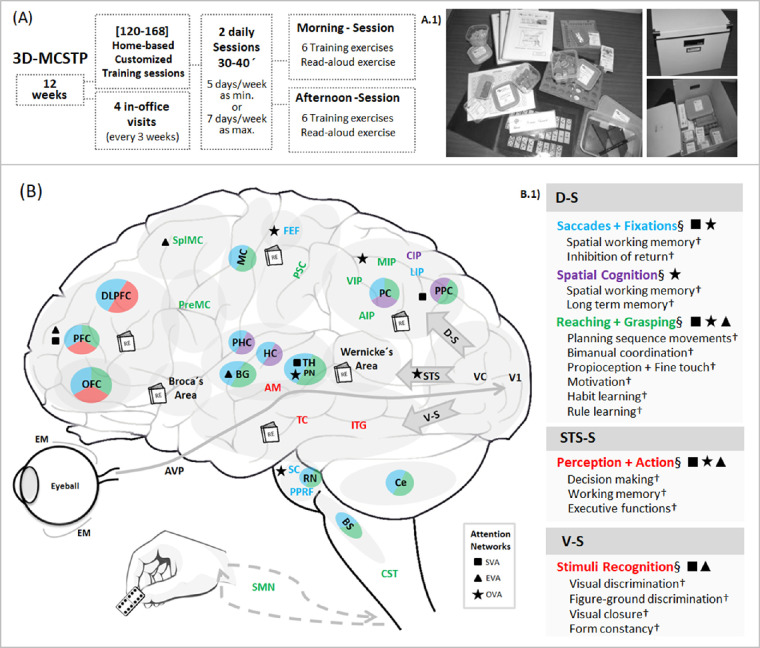
The 3D-MCSTP. (A) Schematic diagram of the intervention group training protocol. (A.1) Pictures of the 3D-MCSTP materials pack. (B) This graph was developed on the basis of primate studies and human neuropsychology data already published.37,44–54 It summarizes the main visual brain structures involved in the performance of six daily visuocognitive and visuomotor behaviors (§B.1); corresponding colors). The gray arrow indicates the afferent visual pathway (AVP) from the eyeball to the V1 area of the occipital lobe. The three thick arrows indicate the beginning of the three main secondary visual pathways involved in the visual processing: dorsal stream (D-S), ventral stream (V-S), and superior temporal sulcus stream (STS-S). The book drawings represent the main brain areas involved in the read-aloud exercise (RE). (B.1) Schematic summary with the three secondary visual pathways, their corresponding six main visuocognitive and visuomotor behaviors, and †their main associated attentional and executive abilities, which correspond to those that patients had to put into play to correctly perform the training program at home. AIP, anterior intraparietal area; AM, amygdala; BG, basal ganglia; BS, brainstem; Ce, cerebellum; CIP, caudal intraparietal area; CST, corticospinal tract; DLPFC, dorsolateral prefrontal cortex; EM, extraocular muscles; EVA, executive visual attention; FEF, frontal eye fields; HC, hippocampus; ITG, inferotemporal gyrus; LIP, lateral intraparietal area; MC, medial cortex; MIP, medial intraparietal area; OFC, orbitofrontal cortex; OVA, orienting visual attention; PC, parietal cortex; PFC, prefrontal cortex; PHC, parahippocampus; PN, pulvinar nuclei; PPC, posterior parietal cortex; PPRF, paramedian pontine reticular formation; PreMC, premotor cortex; PSC, primary somatosensory cortex; RN, red nuclei; SC, superior colliculus; SMN, spinal motor neurons; SplMC, supplementary motor cortex; SVA, sustained visual attention; TC, temporal cortex; TH, thalamus; VC, visual cortex; VIP, ventral intraparietal area.